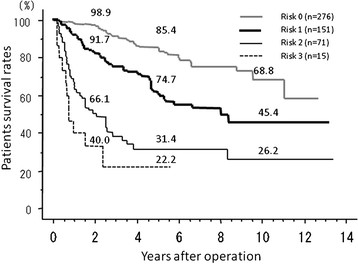
PS rates for risk 0, risk 1, risk 2, and risk 3 at 1 year were 98.9%, 91.7%, 66.1%, and 40.0%, respectively. PS rates for risk 0, risk 1, risk 2, and risk 3 at 1 year were 85.4%, 61.5%, 31.4%, and 22.2%, respectively.